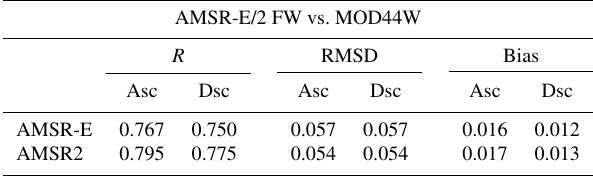
Table 1. Comparisons of FW global averages over AMSR-E (2003–2010) and AMSR2 (2013–2015) periods in relation to the MOD44W static open water map. All products were projected into a consistent 25.0km resolution EASE-Grid format; positive and neg- ative bias indicates FW overestimation and underestimation, respec- tively, relative to the static water map.